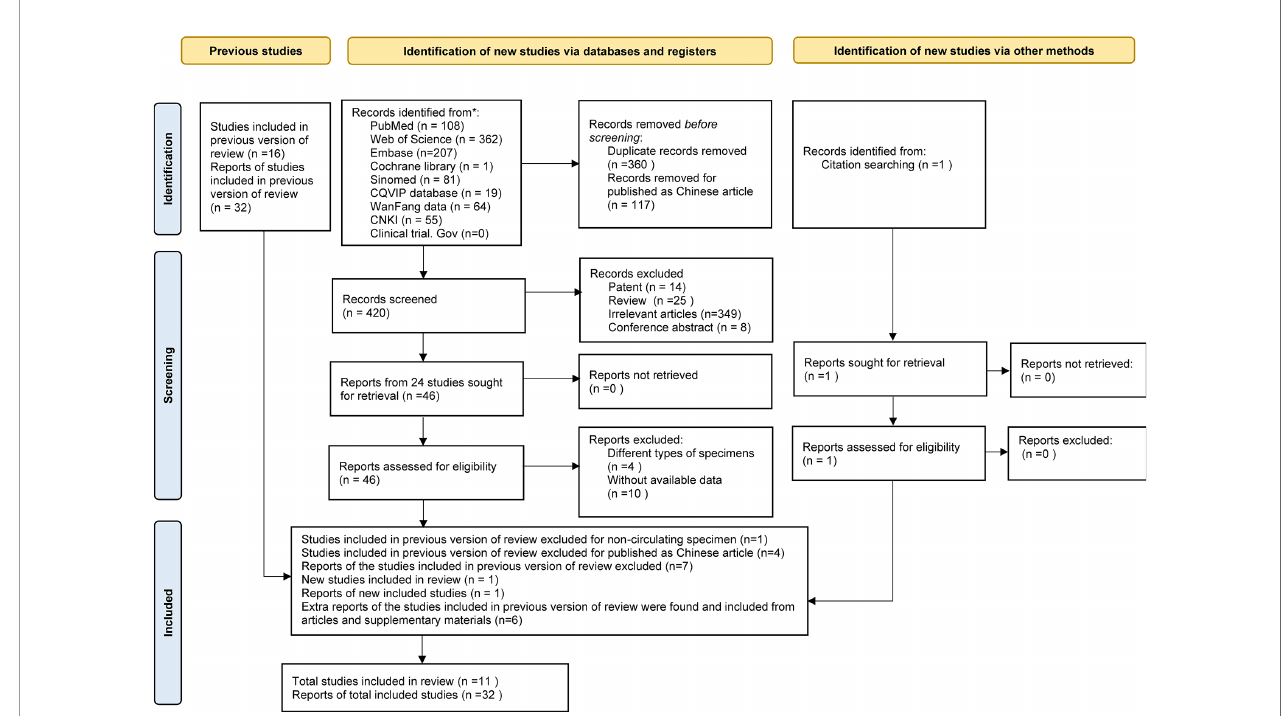
FIGURE 1 | Study selection fl ow